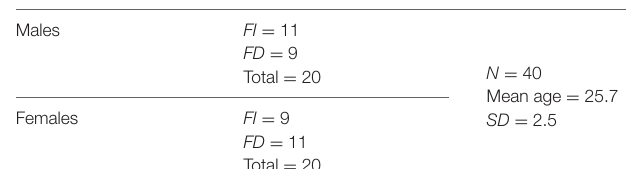
TABLE 1 | Distribution of the sample in gender and